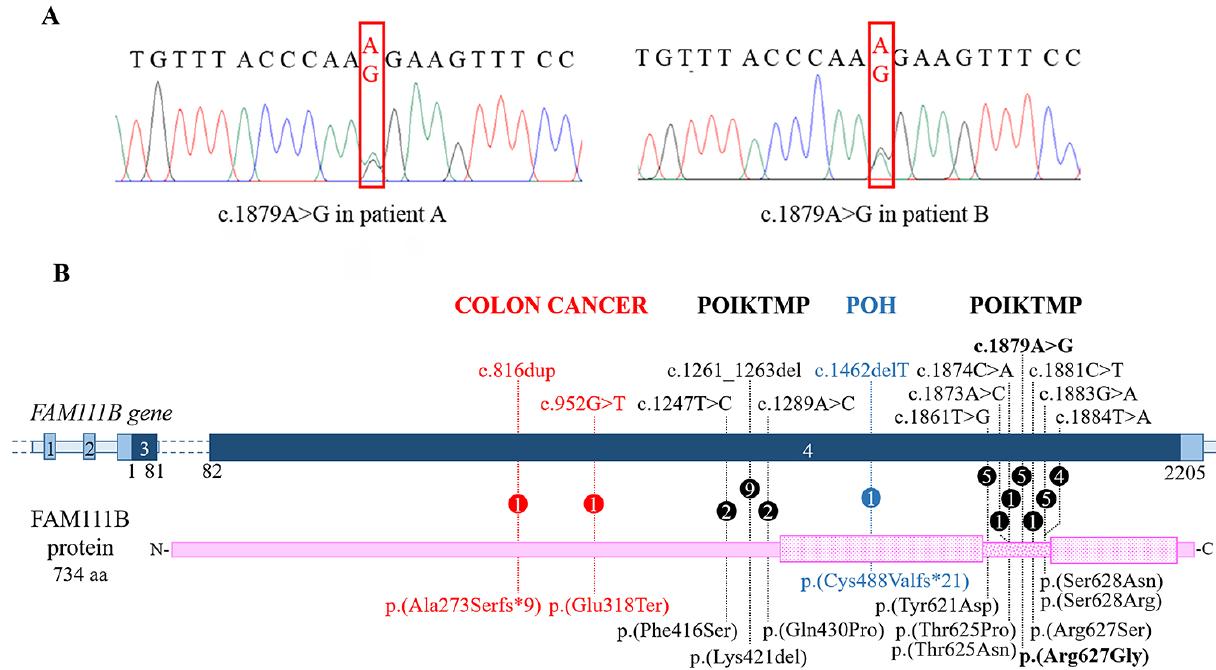
Figure 2 – The mutational repertoire of FAM111B . A) Electropherograms showing the c.1879A>G FAM111B missense variant (framed by the red rectangle) detected in the two unrelated Italian patients. B) Picture summarizing the FAM111B mutational repertoire. The dark blue bar indicates the coding regions of the gene while the non-coding regions are in light blue. The pink bar indicates the protein: the punctate boxes correspond to the protease domain, spanning from amino acid residues 471 to 664 and interrupted by a linker region (dotted bar). Each change is described at DNA (top) and protein level (below). Numbers within the circles specify the number of patients carrying the variant. Pathogenic variants associated with POIKTMP, POH, and colon cancer are written in black, blue and red,